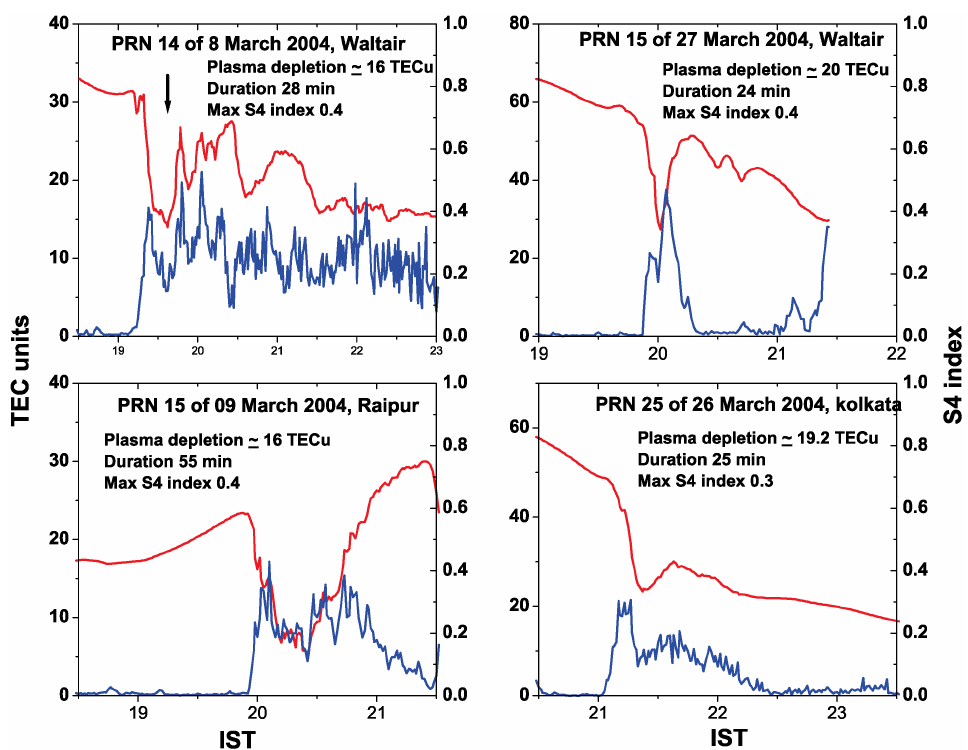
Fig. 5. Some examples of scintillations (S4 index) associated with TEC depletions observed in the GPS data at four typical Indian